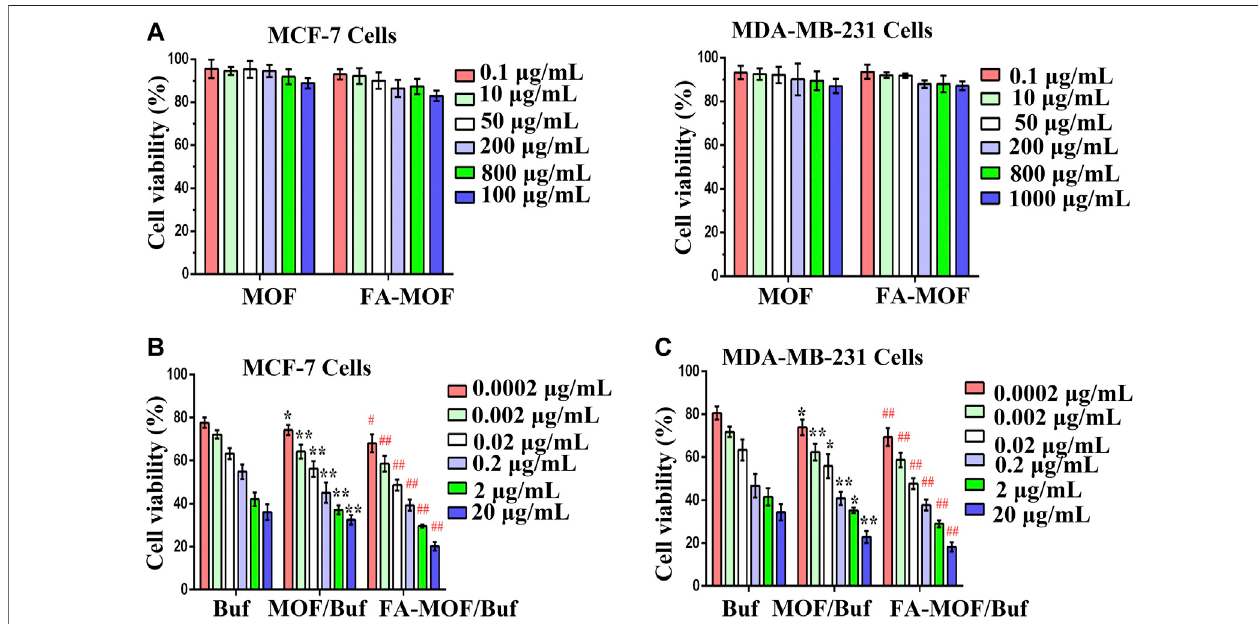
FIGURE1| Invitro cytotoxicityofMOFsand FA-MOF againstMDA-MB-231 andMCF-7 cells (A) Free Buf,Buf-labeled MOF (MOF/Buf), andBuf-labeledFA-MOF. (FA-MOF/Buf)againstMCF-7cells (B) andMDA-MB-231cells (C) ConcentrationsusedinthecytotoxicityexperimentswerebasedonthefreeBufanditscounterpartof loaded Buf into the MOF. Cell viability was measured by the CCK-8 assay by 48-h treatment. The data are presented as means ± SD ( n (cid:1) 3). * p < 0.05 and ** p < 0.01 (MOF/Buf vs. Buf); # p < 0.05 and ## p < 0.01(FA-MOF/Buf vs. MOF/Buf).